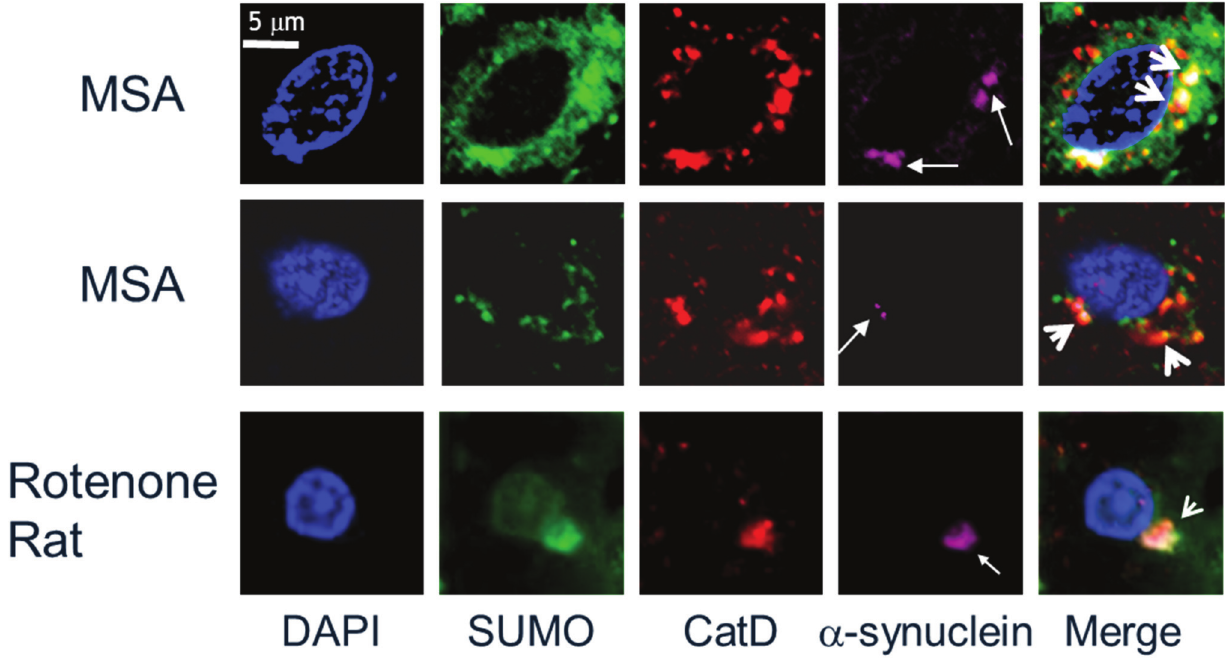
Figure 3. SUMO-1 marks lysosomes in (cid:2)-synuclein inclusion body bearing cells in multiple system atrophy and rotenone rat (cid:2)-synucleinopathy model tissue. Immunofluorescence triple labelling for SUMO-1, the lysosome marker, CatD, and (cid:2)-synuclein reveals frequent colocalization of SUMO-1 with lysosomes (arrowheads) in close proximity to (cid:2)-synuclein inclusion bodies (arrows)